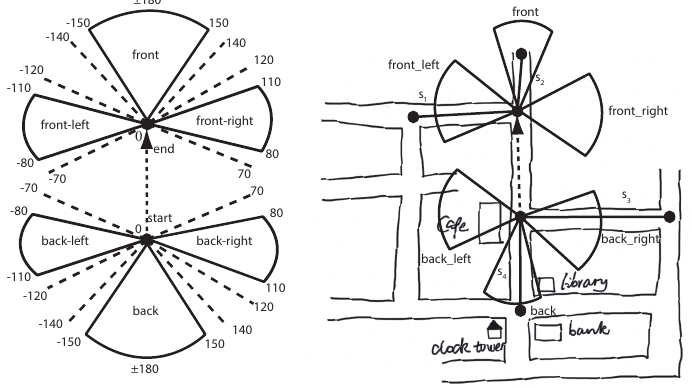
Figure 3: Definition (upper left) and example (right) of analyzing orientation of connected street